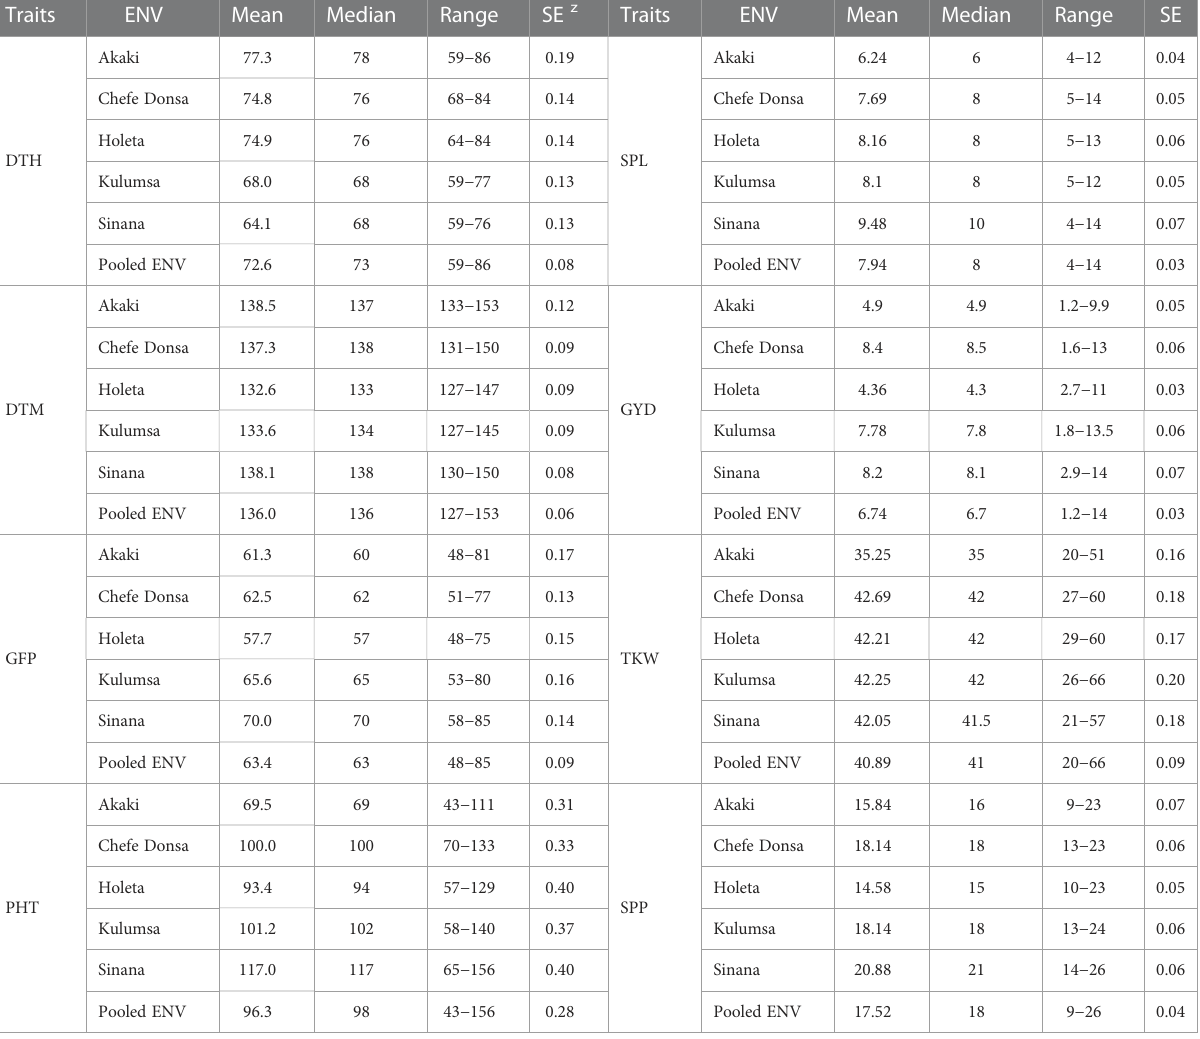
TABLE 1 Descriptive statistics for days to heading (DTH, in days), days to physiological maturity (DTM, in days), grain fi lling period (GFP, in days), plant height (PHT, in cm), spike length (SPL, in cm), grain yield (GYD, in t ha -1 ), thousand kernel weight (TKW, in g), and the number of spikelets